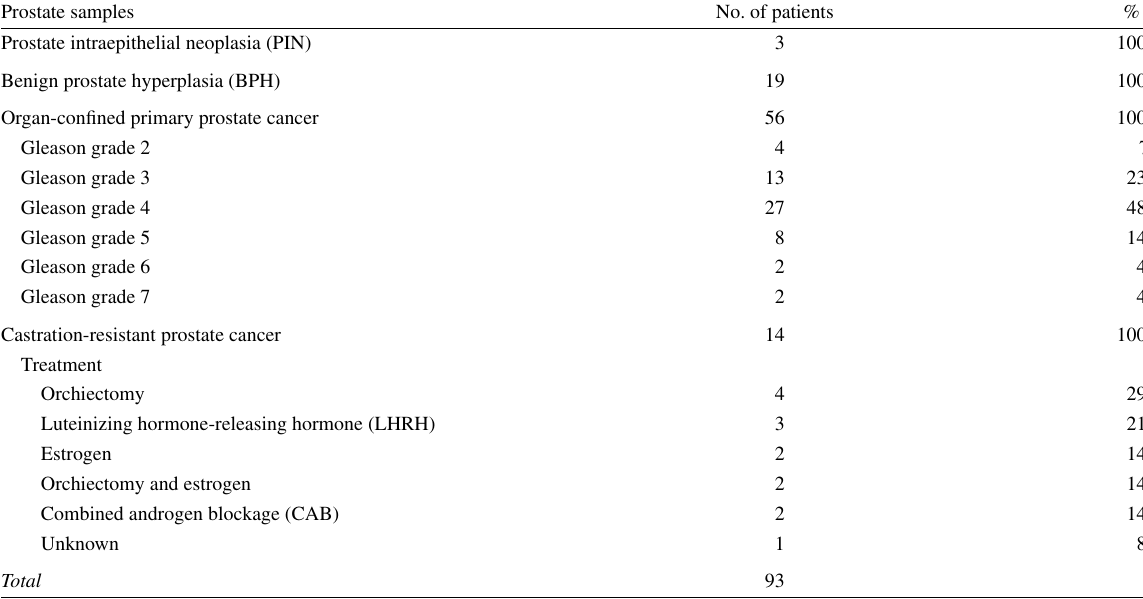
Prostate cancer specimens